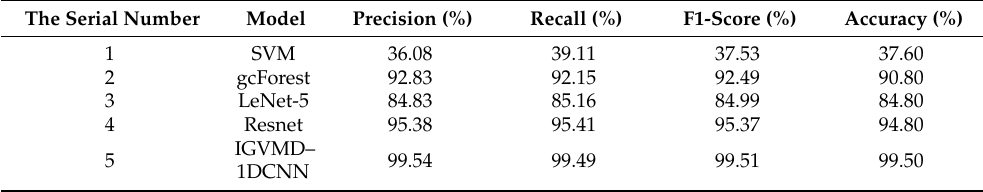
Table 9. Comparison results with the different models using the gearbox